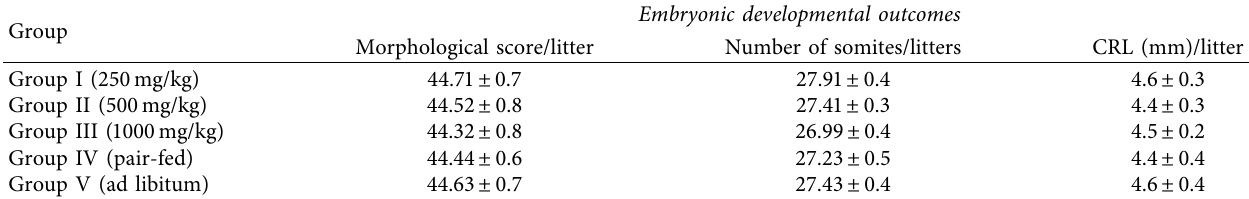
Table 1: Embryonic outcome variables across experimental groups after treatment with the 80% ethanol fruit extract of Embelia schimperi .